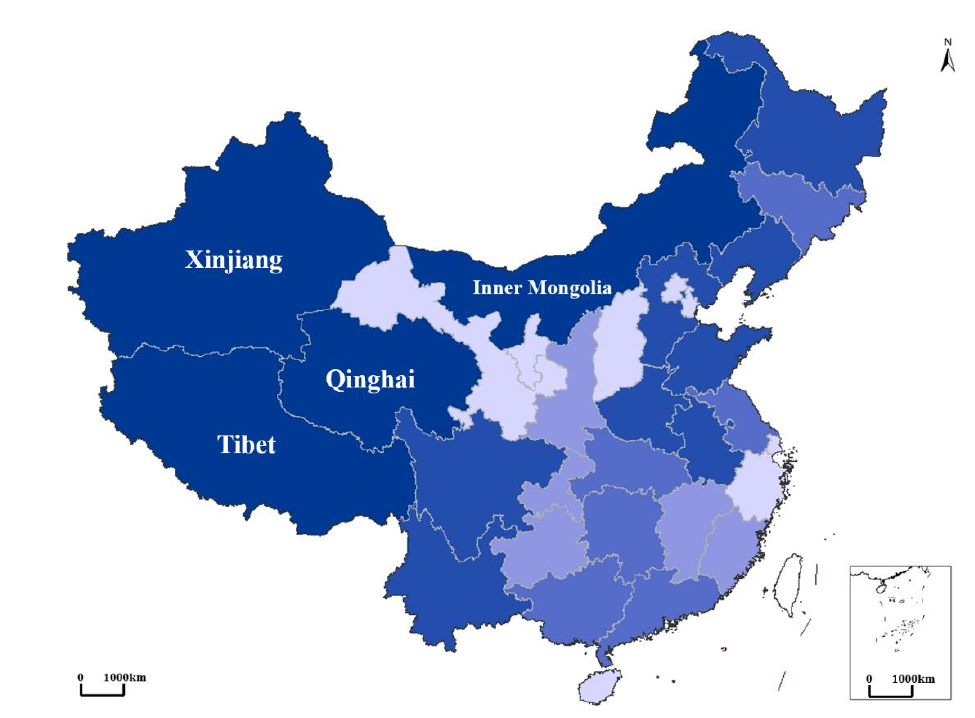
Figure 3. Spatiotemporal pattern of Brucellosis in: ( a ): outbreak period (2003 – 2014); ( b ) mild period (2014 – 2017); ( c ) recurrence period (2017 – 2019). * 1: most likely cluster; 2: the secondary cluster Ⅰ ; 3: the secondary cluster Ⅱ ; 4: the secondary cluster Ⅲ .